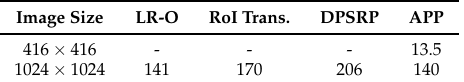
Table 8. Speed comparison with other methods (unit: ms). The LR-O, RoI Trans, and DPSRP denote RoI Transformer and the Light-Head R-CNN OBB, deformable Position Sensitive RoI pooling, respectively [8].